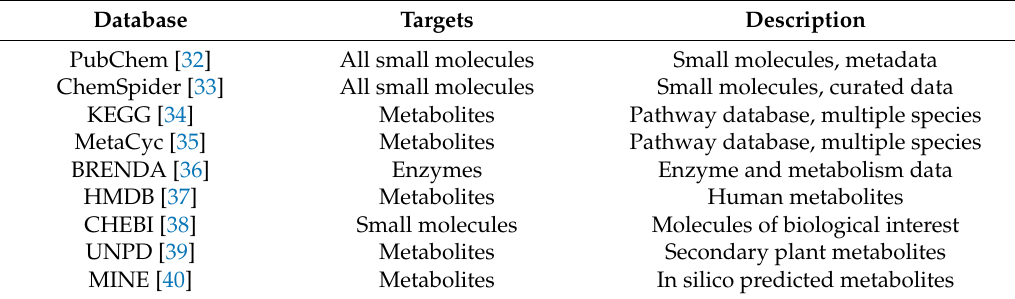
Table 2. Overview of selected compound databases commonly used for compound